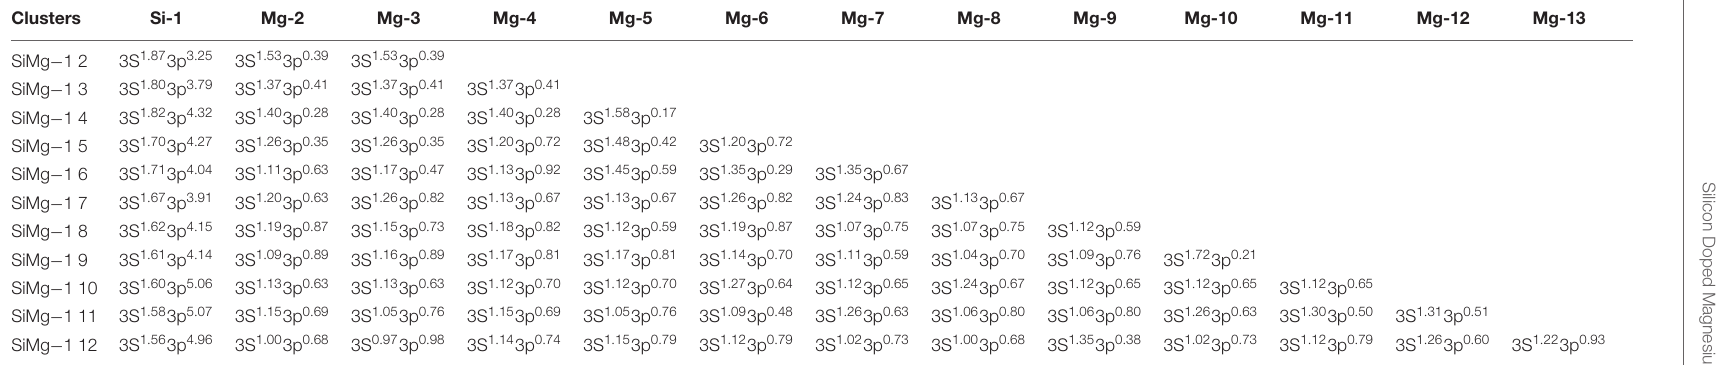
TABLE 5 | NEC of the ground state of SiMg + 1 n ( n = 2–12) clusters. Clusters Si-1 Mg-2